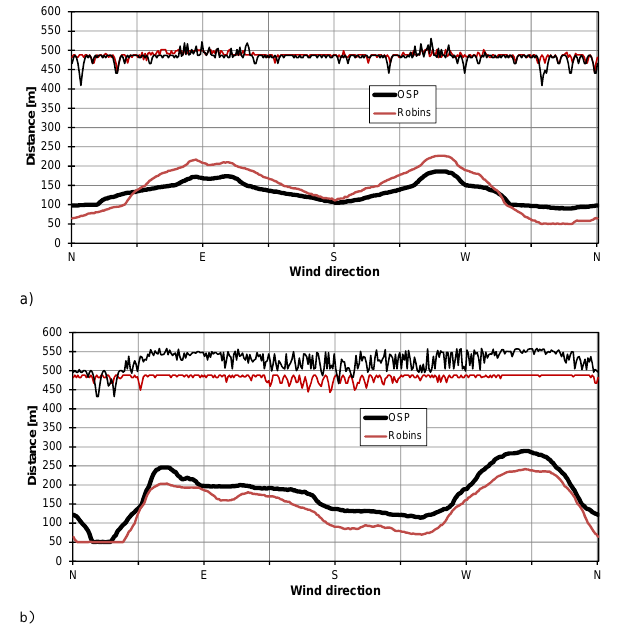
Figure 2. Separation distances for (a) Linz and (b) Kittsee. For details, see text.